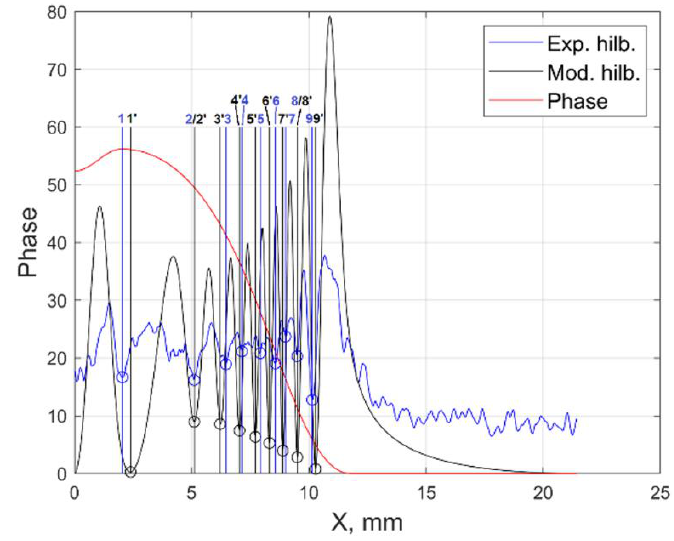
Figure 5. The experimental and reconstructed in the B-channel Hilbertograms of the flame cross section y = 6 mm.